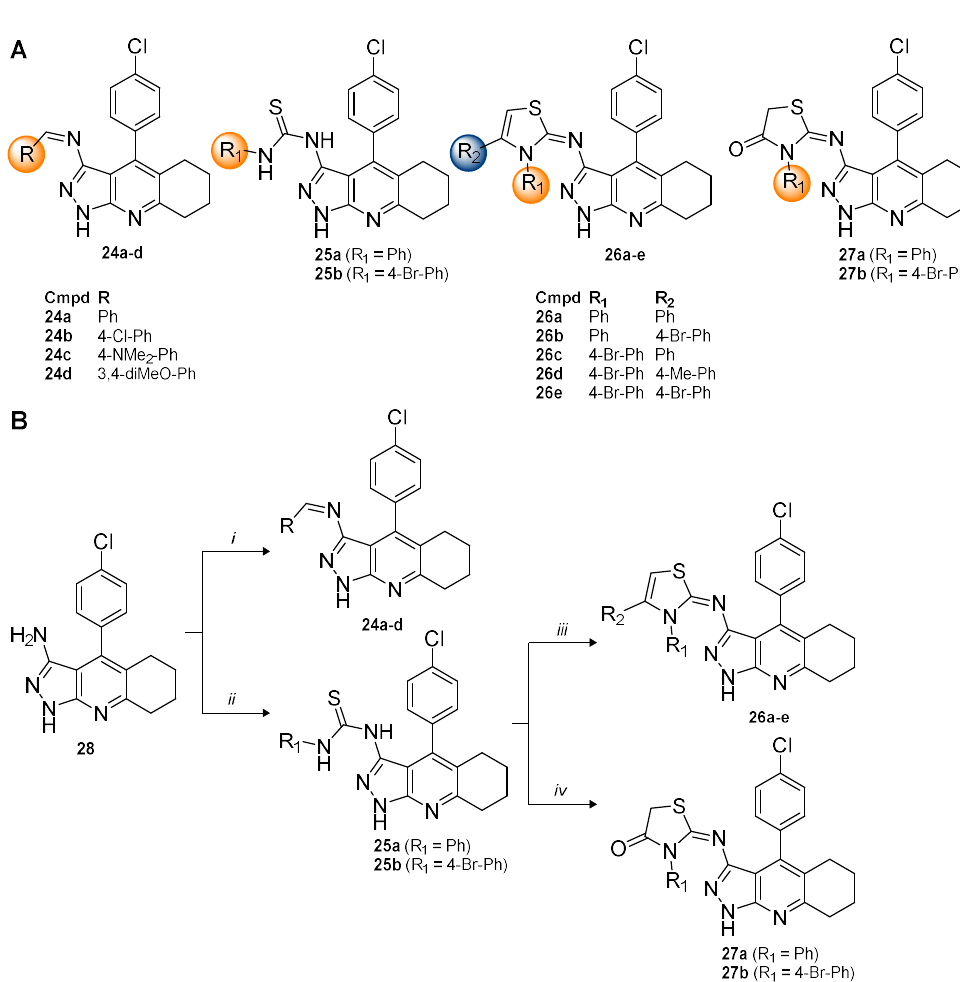
Figure 6. Molecular modeling of 27a (rose) and 27b (purple) with h AChE showing the interaction with the PAS (adapted from [86], with permission from Elsevier). Key interactions noted are the tricyclic core showing favorable hydrophobic interactions with Tyr341, Tyr337, Phe338, and Val294,